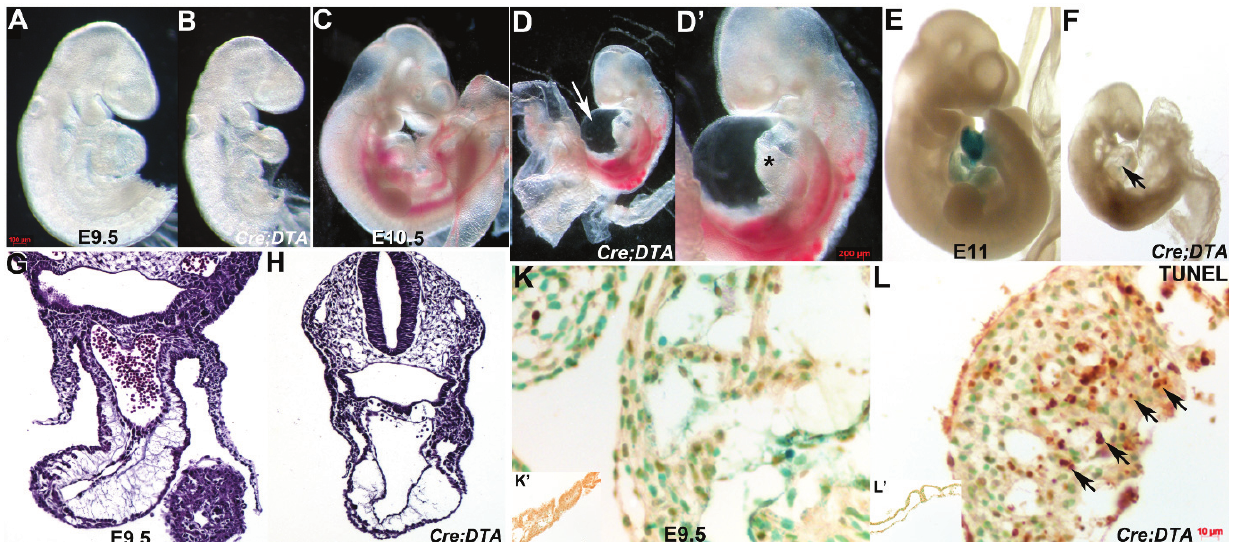
Figure 4. Nfatc1 Cre lineage is required for heart development and in utero